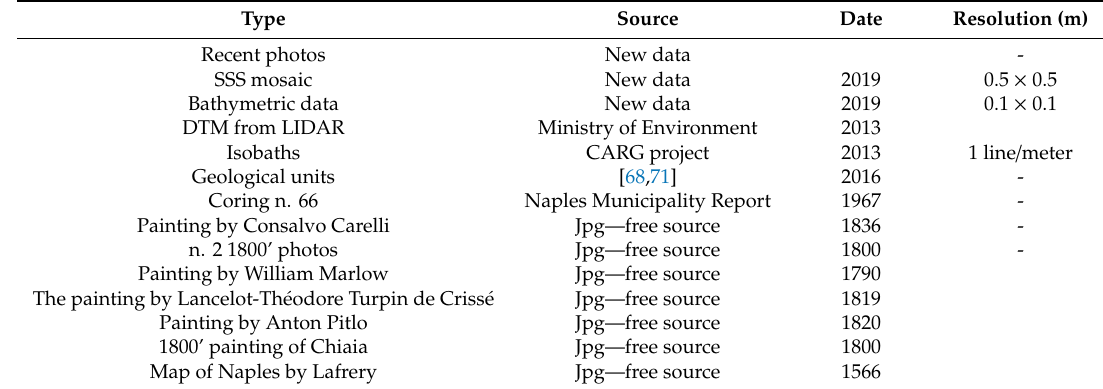
Table 1. List of data and sources used in this research.